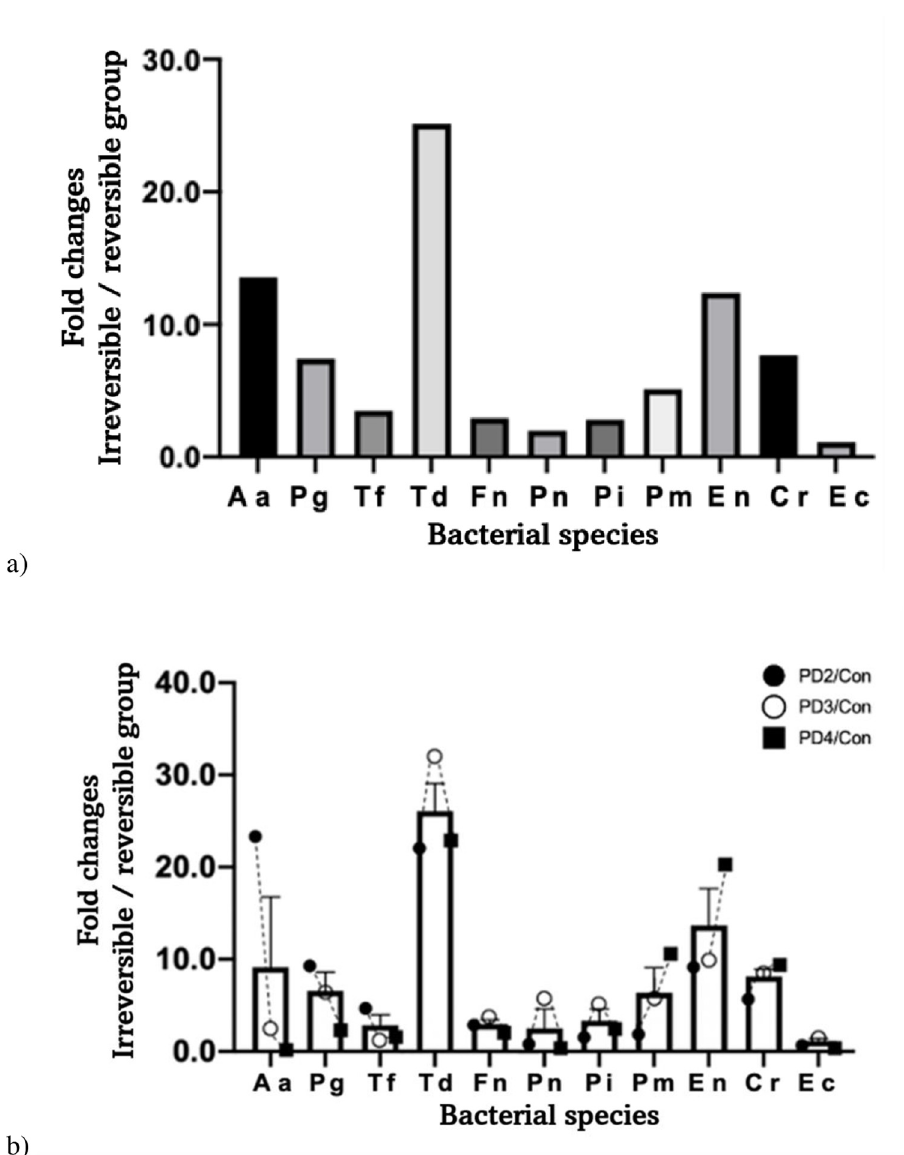
Fig 5. Mean numbers of bacteria in comparison between groups. (A) Comparison of fold changes between the reversible and irreversible groups. PD2: PD2 group, PD3: PD3 group, PD4: PD4 group, con: Reversible